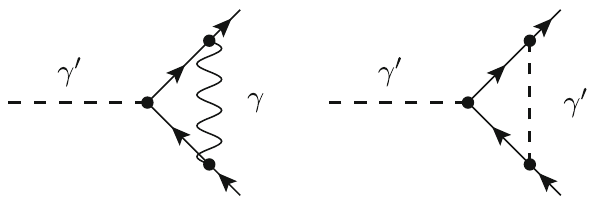
Fig. 8 Diagrams contributing to the interaction of the fdf scalar with fermions at the one-loop level. The right diagram vanishes according to the ( − 2 (cid:3))